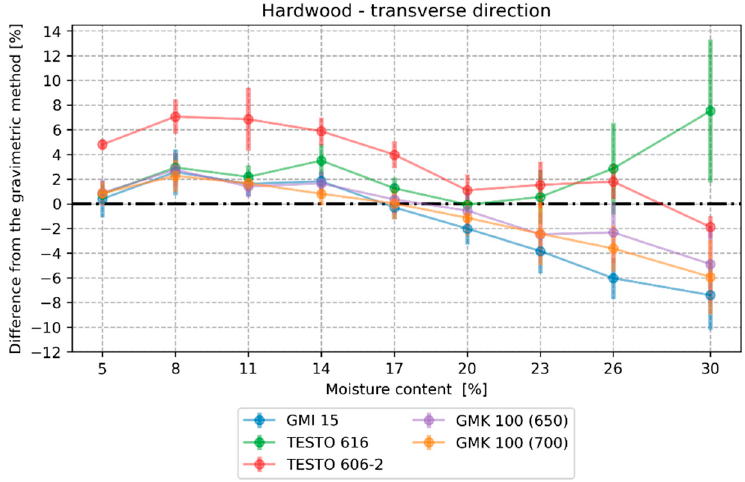
Figure 4. Comparison of average values of differences from the gravimetric method in the transverse direction of beech wood using selected moisture meters GMI 15, GMK 100, Testo 616 and Testo 606-2 at different moisture conditions and GMI 100 at different instrument settings of 650 kg/m 3 (650) and 700 kg/m 3 (700).